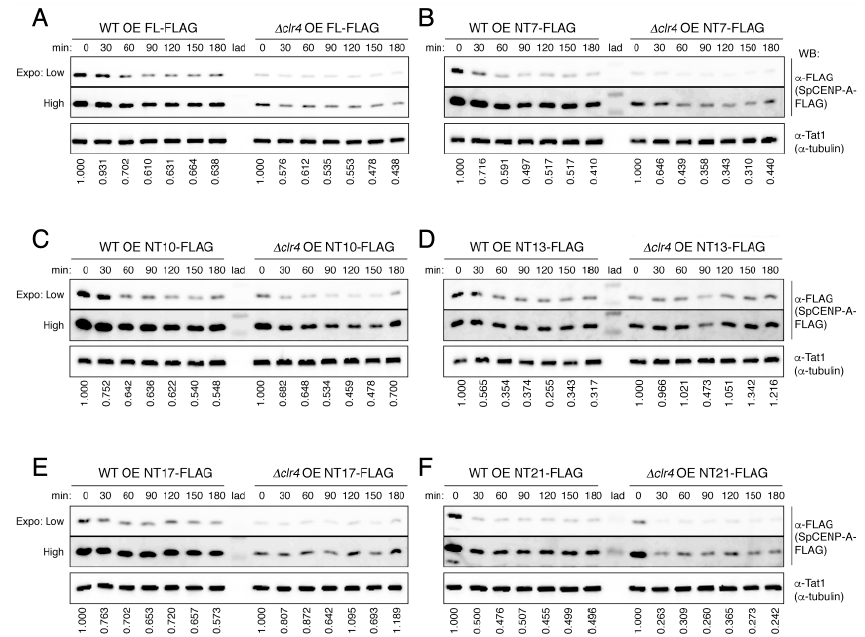
Figure 3. Heterochromatin ‐ mediated protection of SpCENP ‐ A against proteolytic degradation. Cycloheximide (CHX) chase assay of wild ‐ type and heterochromatin ‐ disrupted Δ clr4 cells expressing Cycloheximide (CHX) chase assay of wild-type and heterochromatin-disrupted